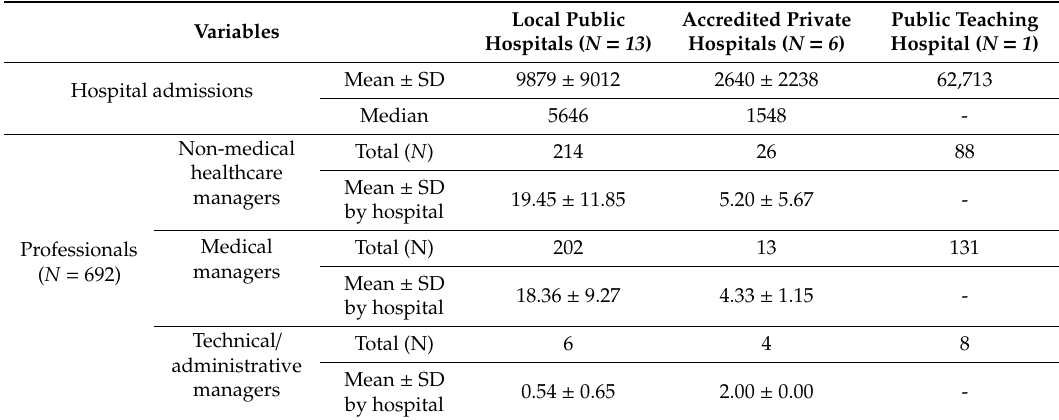
Table 1. Description of the hospitals and providers investigated (data refer to